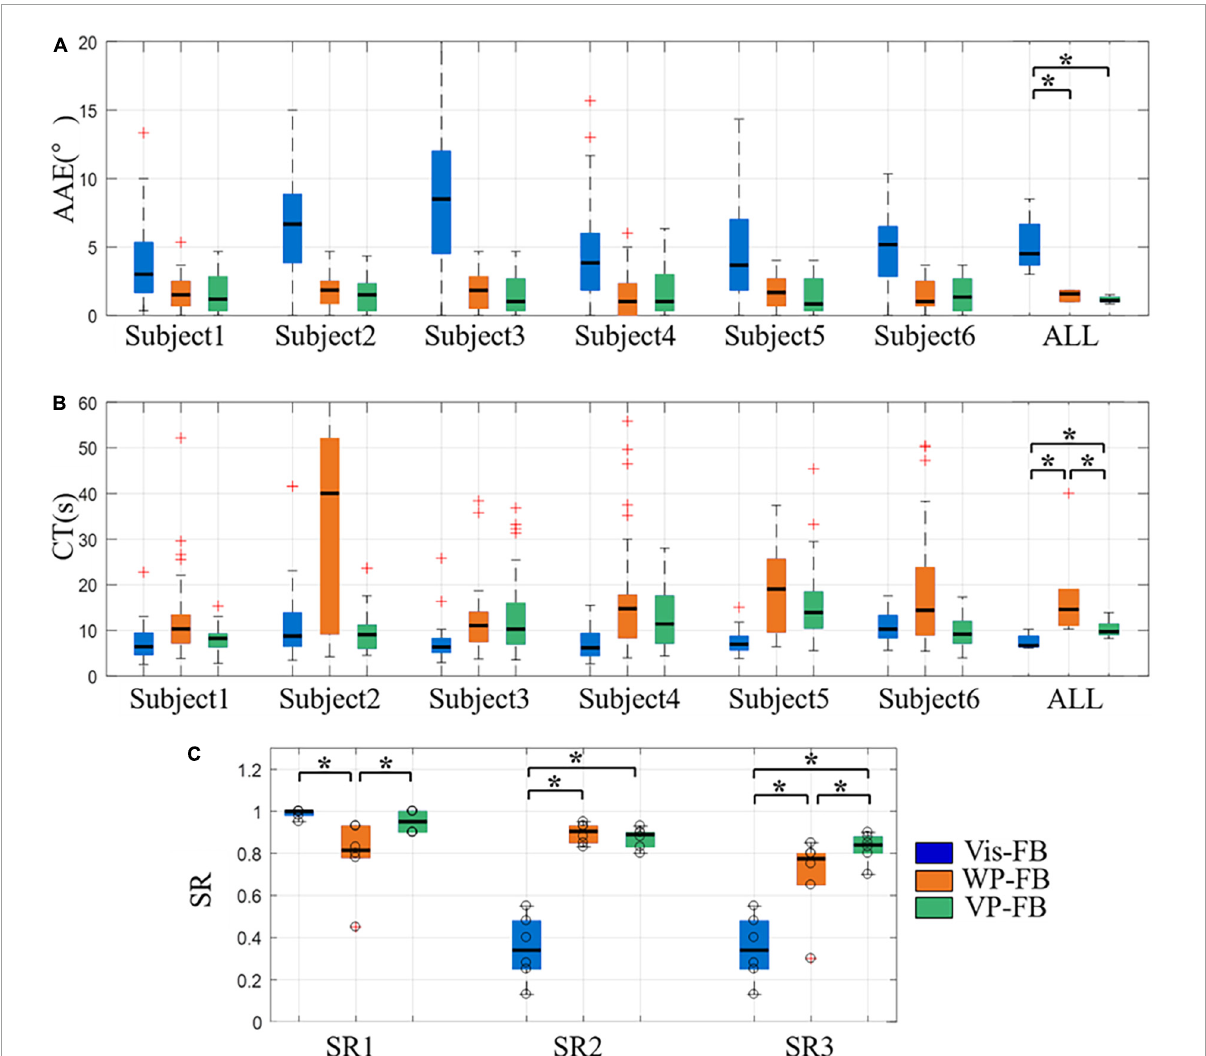
FIGURE7 The control performance of the arm prosthesis under different feedback methods, (A) AAE, (B) CT, (C) SR. Boxplots depict the median ( line ), interquartile range ( box ), maximal/minimal values ( whiskers ), and outliers ( crosses ). The hollow circle denotes the results of each subject in panel (C) . A star denotes the statistically significant differences (* p < 0.05). AAE, absolute angular error; CT, completion time; SR1 to SR3, success rate when considering time threshold, angle threshold, and combination of the time and angle thresholds, respectively. ALL